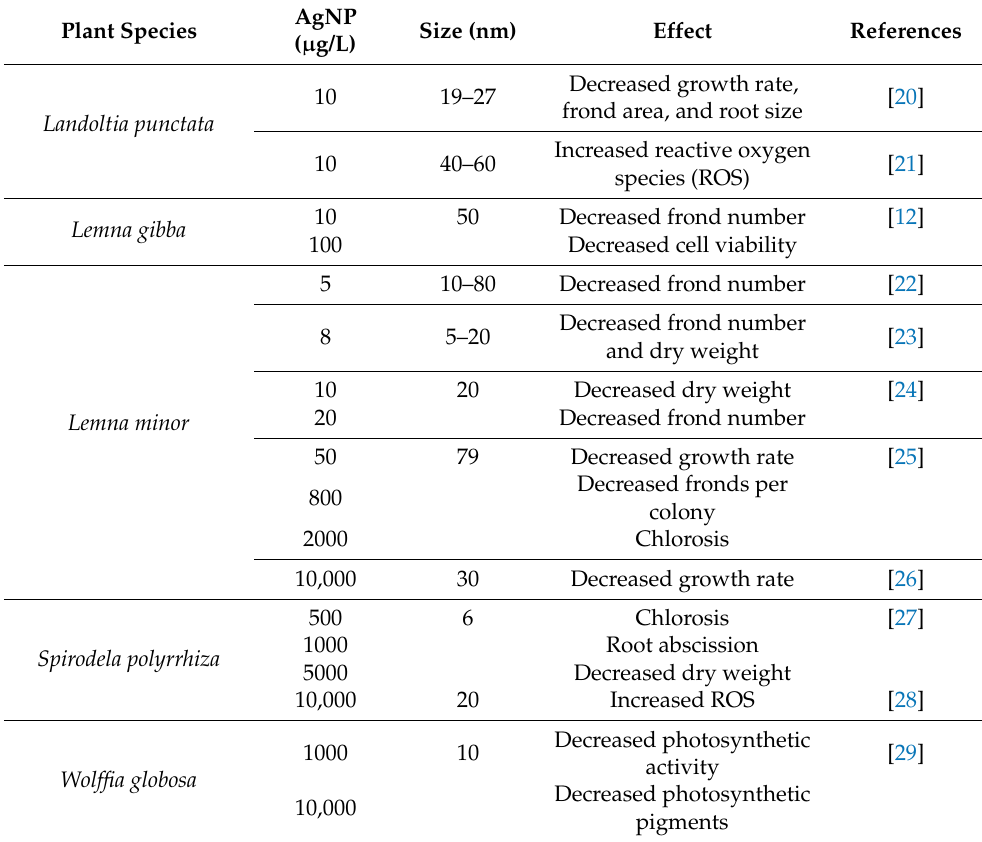
Table 1. Toxicity effects of silver nanoparticles (AgNP) of varying size on floating species of the family Araceae (AgNP concentrations listed indicate the lowest concentrations with an observed effect).